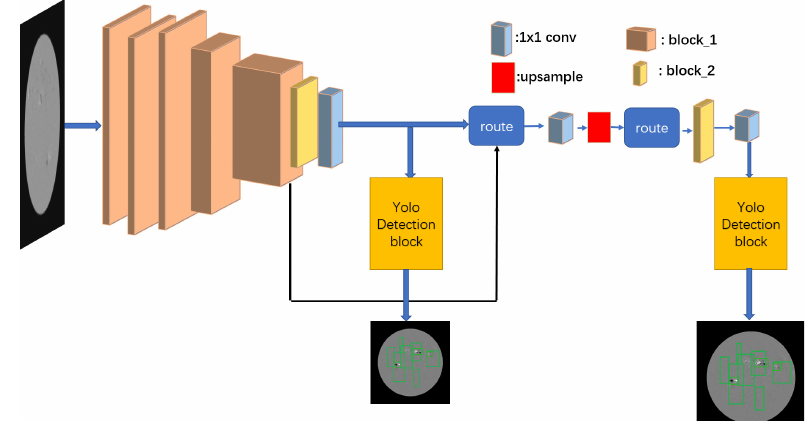
Figure 4. Flowchart of YOLO V3 model.